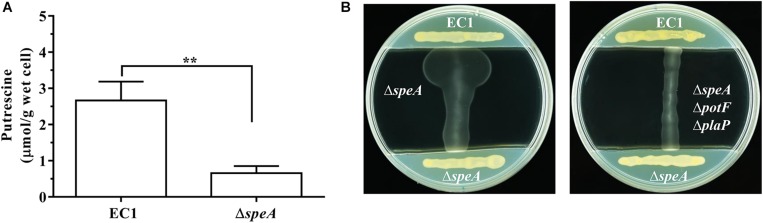
Deletion of speA in D. zeae strain EC1 decreased cellular level of putrescine and abrogated its ability to promote swimming motility. (A) Quantitative measurement of cellular putrescine content in strain EC1 and the speA deletion mutant ΔspeA. The bacterial strains were grown in minimum medium till OD600 reached about 1.7. Intracellular putrecine molecules were extracted by freezing and thawing with liquid nitrogen, and benzoylated with benzoyl chloride for analysis with LC-MS. The experiment was repeated three times and error bars denote s.e. (B) Putrescine induction of bacterial motility required functional transporters. Strain EC1 and mutant ΔspeA were grown respectively on the opposite ends of LB plate as indicated to precondition the medium. After 12 h, the middle section of the plate was removed and filled with swimming agar medium. Upon solidification, the mutants ΔspeA (left panel) and ΔspeAΔpotFΔplaP (right panel) were lined vertically to strain EC1 and the mutant ΔspeA as indicated. The plates were cultured for 24 h at 28°C before photographing. The experiment was repeated three times with similar results. ∗∗P < 0.01.